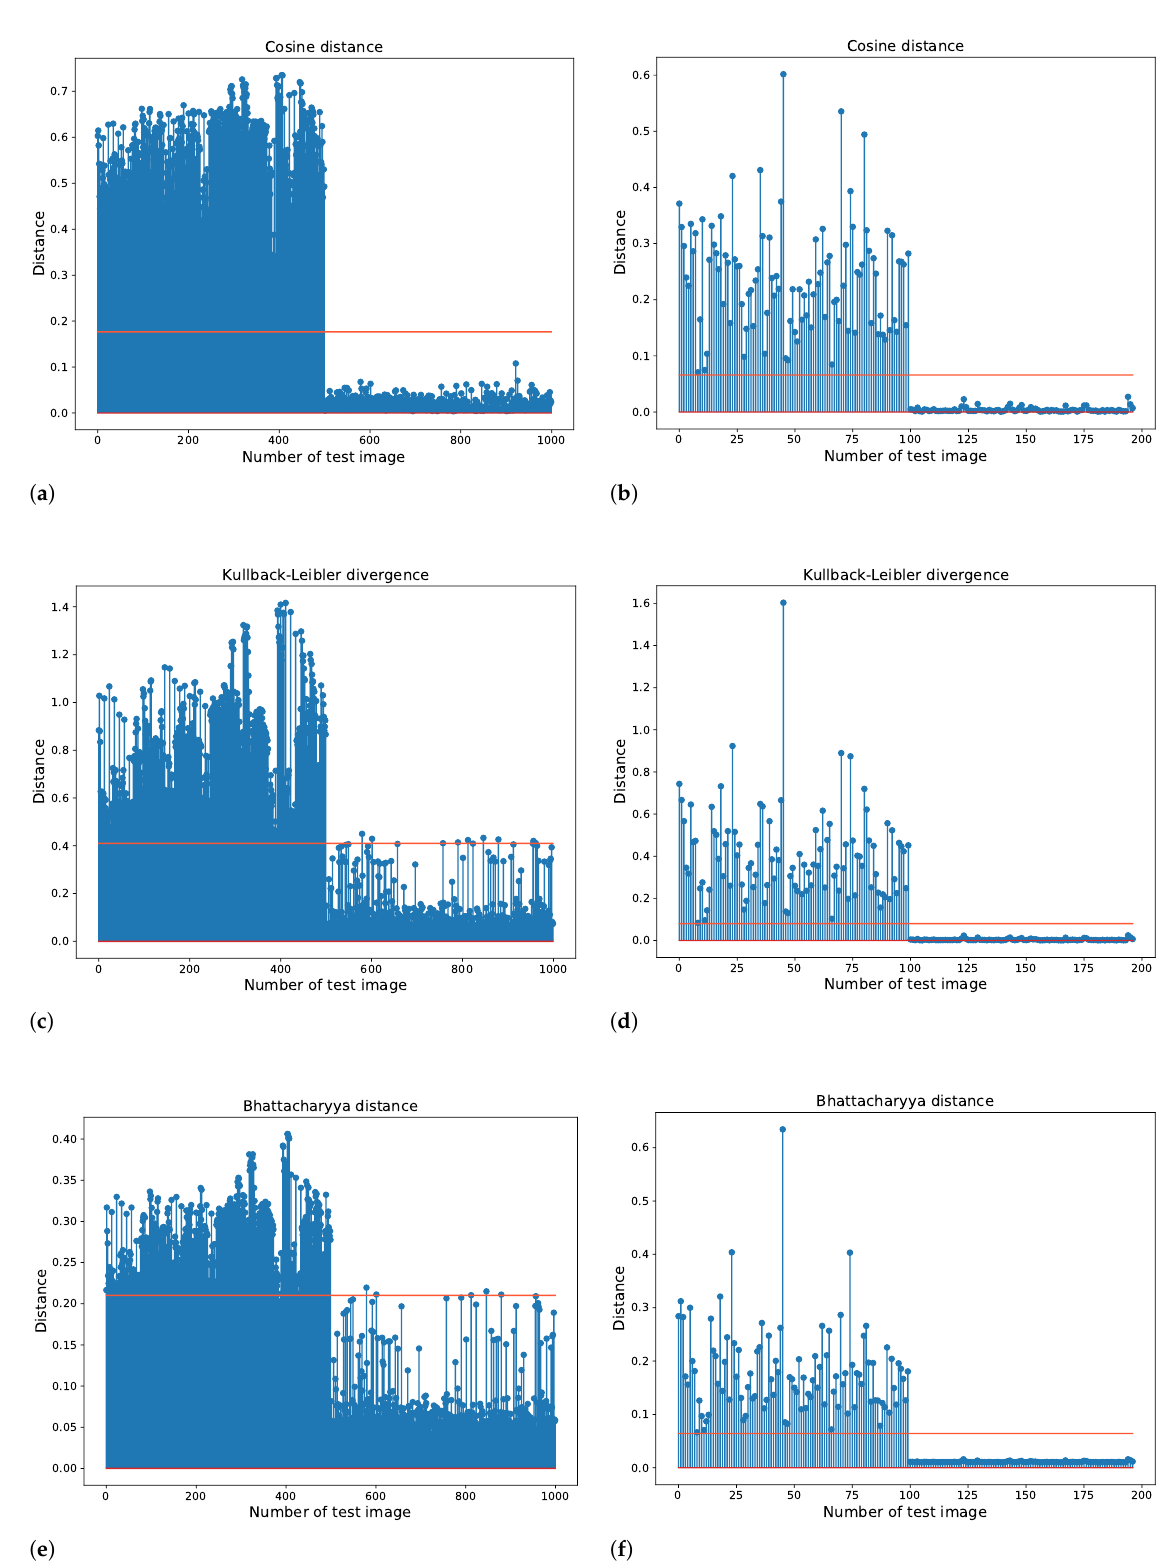
Figure 3. The obtained distances on the considered CT and CXRs datasets, and related threshold TH (the red lines) set using (2). The distances are: ( a ) Cosine for CT, ( b ) Cosine for CXRs, ( c ) Kullback–Leibler divergence for CT, ( d ) Kullback–Leibler divergence for CXRs, ( e ) Bhattacharyya distance for CT, and ( f ) Bhattacharyya distance for CXRs. The χ 2 distance behaves as in the KL and Bhattacharyya distances; hence, it is not explicitly shown. The results have been obtained by selecting N T = 500 reference images and a number N bin = 50 of histogram bins. The threshold in (2) has been set to η = 2 for the CT dataset and to η = 1.4 for